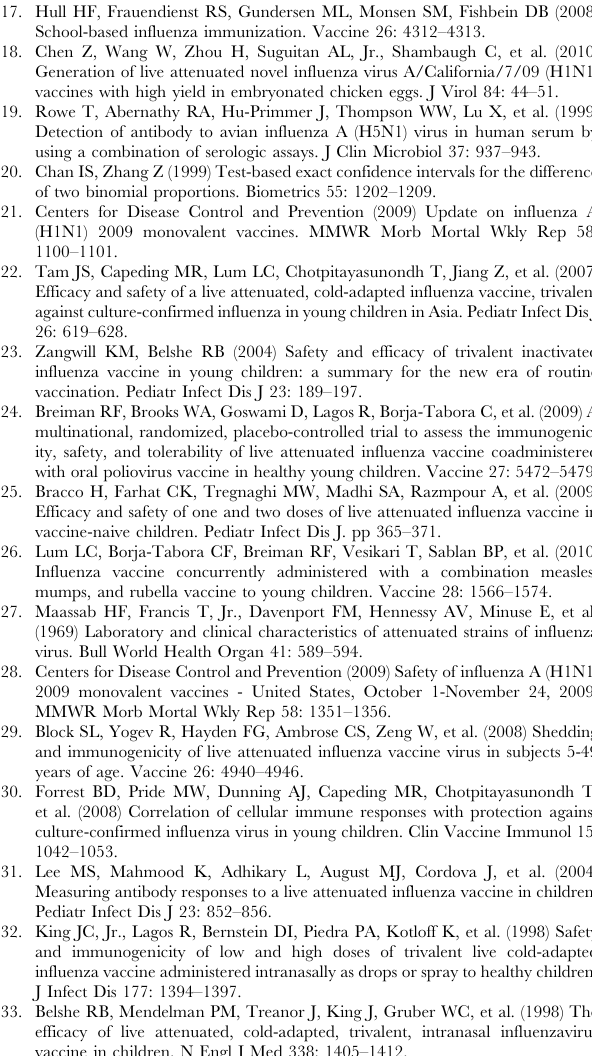
Table S2 Adverse Events Reported in Adults # 15 Days After Dose (Safety